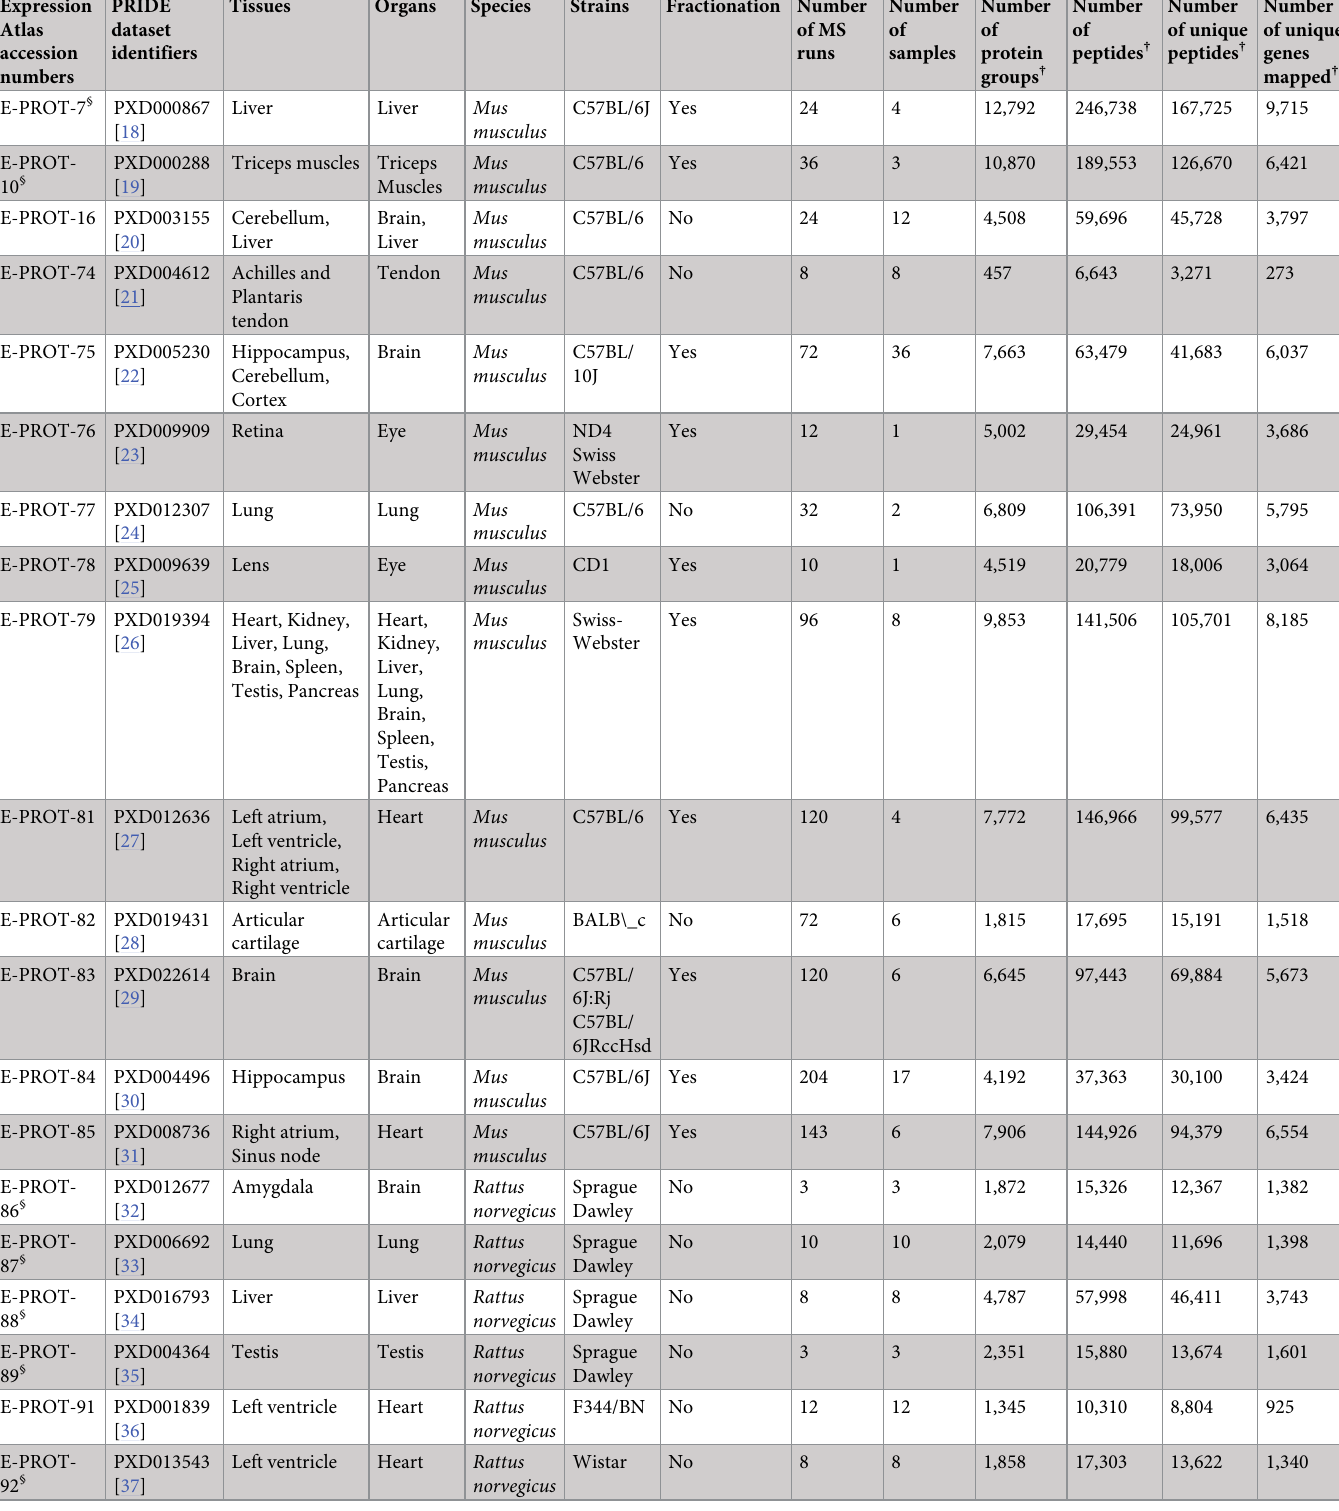
Table 1. List of mouse and rat proteomics datasets that were reanalysed. Expression